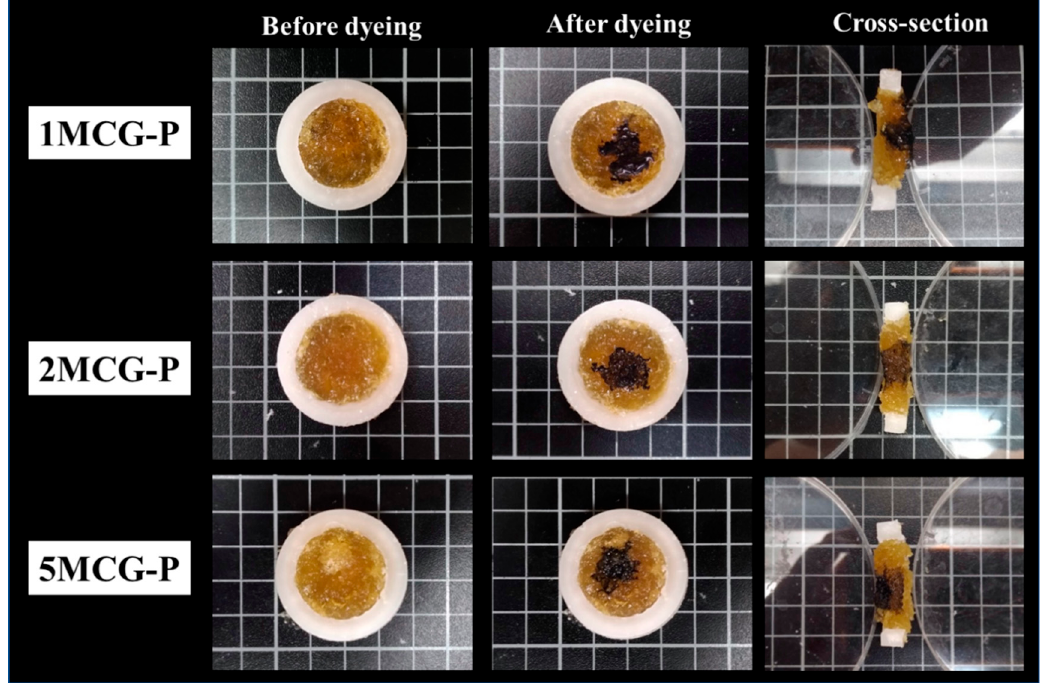
Figure 8. Interconnected pores of CS/Gel/MMT/PCL bone scaffolds.